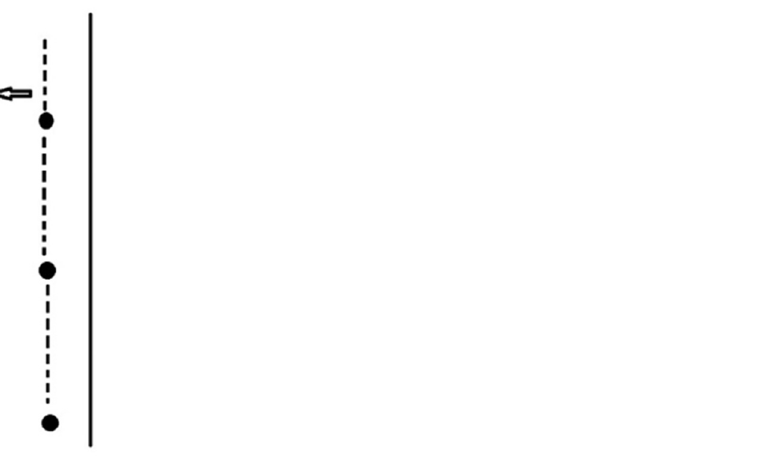
Figure 2. Preview of the corridor for short turn execution ( a )—corridor width for AS; ( b )—corridor width for IS).